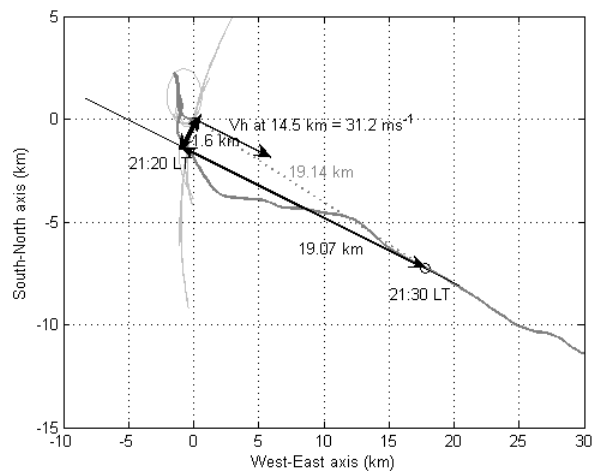
Fig. 9. (Heavy grey): Balloon B1 trajectory in the horizontal plane. (Light grey) the closest positions of the air parcels from the radar site, assuming a frozen-in advection in an uniform and constant hor- izontal wind. The particular case of an altitude of 14.5km is also shown (see text for more